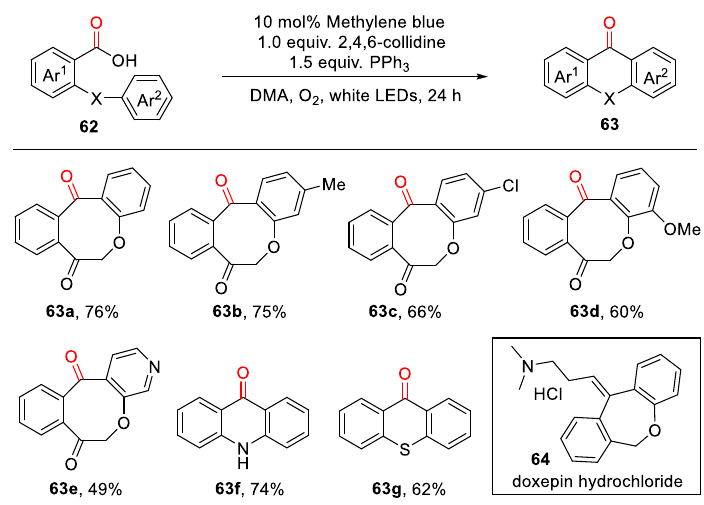
Scheme 17. Acyl radical-mediated intramolecular cyclization of aromatic acids